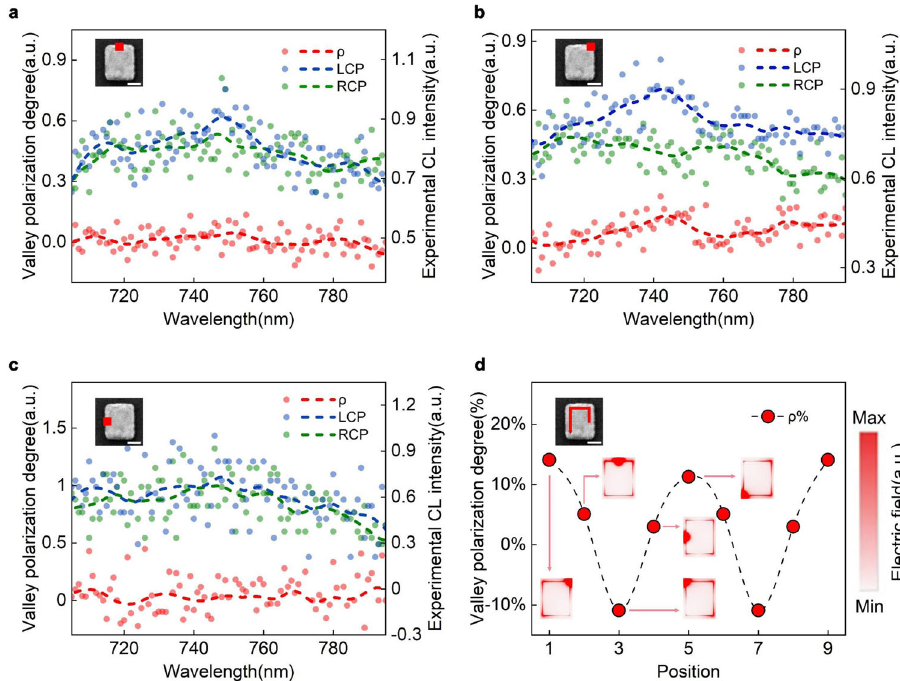
Fig. 3 Manipulation of the valley polarization. Normalized LCP and RCP components of CL emitted along + z direction obtained by CP-resolved CL microscopy with a linear polarizer (550 – 1500 nm) and a quarter-wave plate (690 – 1200 nm) under 5 keV electron-beam excited at ( a ) top middle, ( b ) top right, and ( c ). middle left of nanoantenna with excitation positions shown in insets. The dots are experimental results and the dashed lines describe the trend. The peaks of three spectra almost locate at the same wavelengths with ( a ) 748, ( b ) 742, and ( c ) 747 nm and the fl uctuations in spectra may result from thermal perturbation at room temperature and low excitation voltage. d Degree of valley polarization calculated at resonance peaks extracted from spectra which were obtained by electron-beam moving along the track represented by red line and arrow shown in inset, and a remarkable ability to control valley polarization is shown as ρ changing from almost zero to 14.1% and fi nally reducing to − 10.9% at various excitation positions. The excitation position- dependent simulated electric fi elds are shown in insets, corresponding to right ordinate.